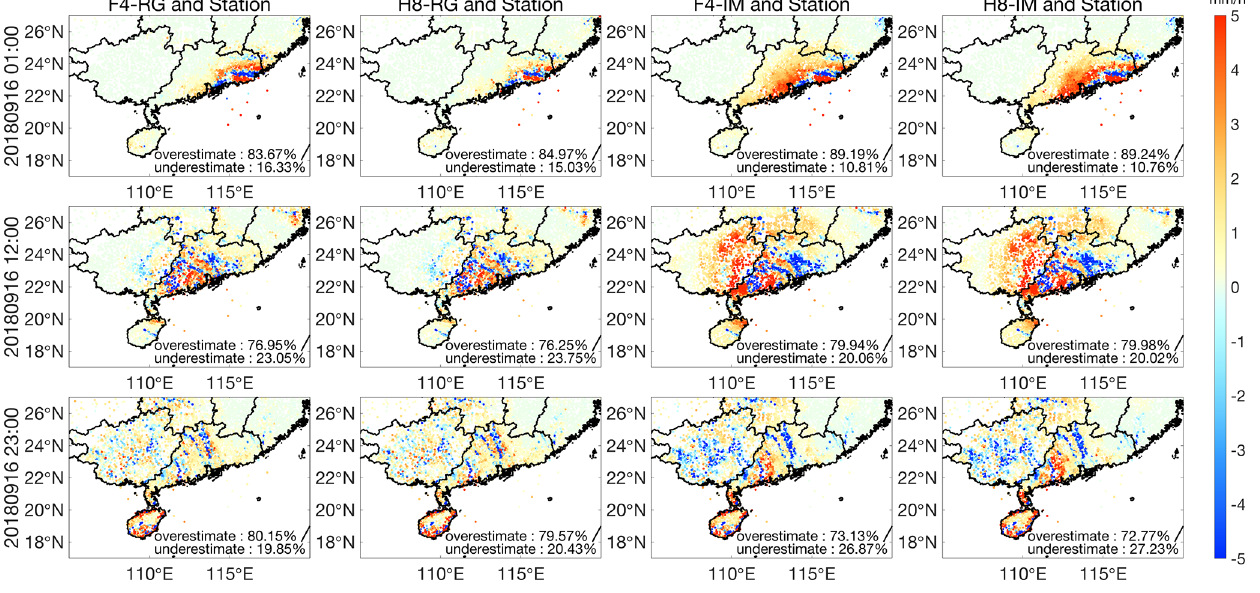
Figure 8. Differences in hourly precipitation between F4-RG, H8-RG, F4-IM and H8-IM and the ground rain-gauge observations at instants steps (01:00UTC on 16 September 2018, 12:00UTC on 16 September 2018, and 23:00UTC on 17 September